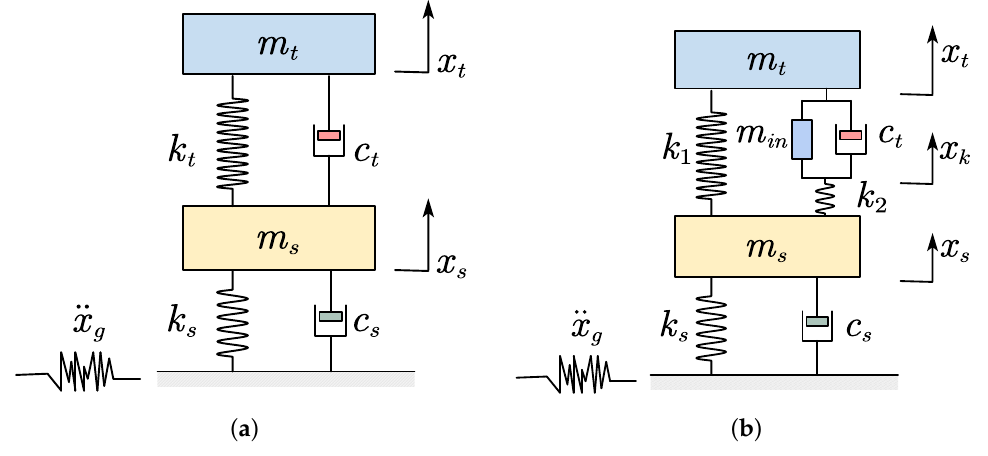
Figure 2. The schematic diagram of TMD and TMDI: ( a ) TMD and ( b ) TMDI. It is assumed that the whole system is excited by the base acceleration ¨ x g , the equation of motion for the dynamic system indicated above could be obtained with the equilibrium of forces. Accordingly, the kinetic equations for both the TMD and TMDI are expressed in Equations (1) and (2),